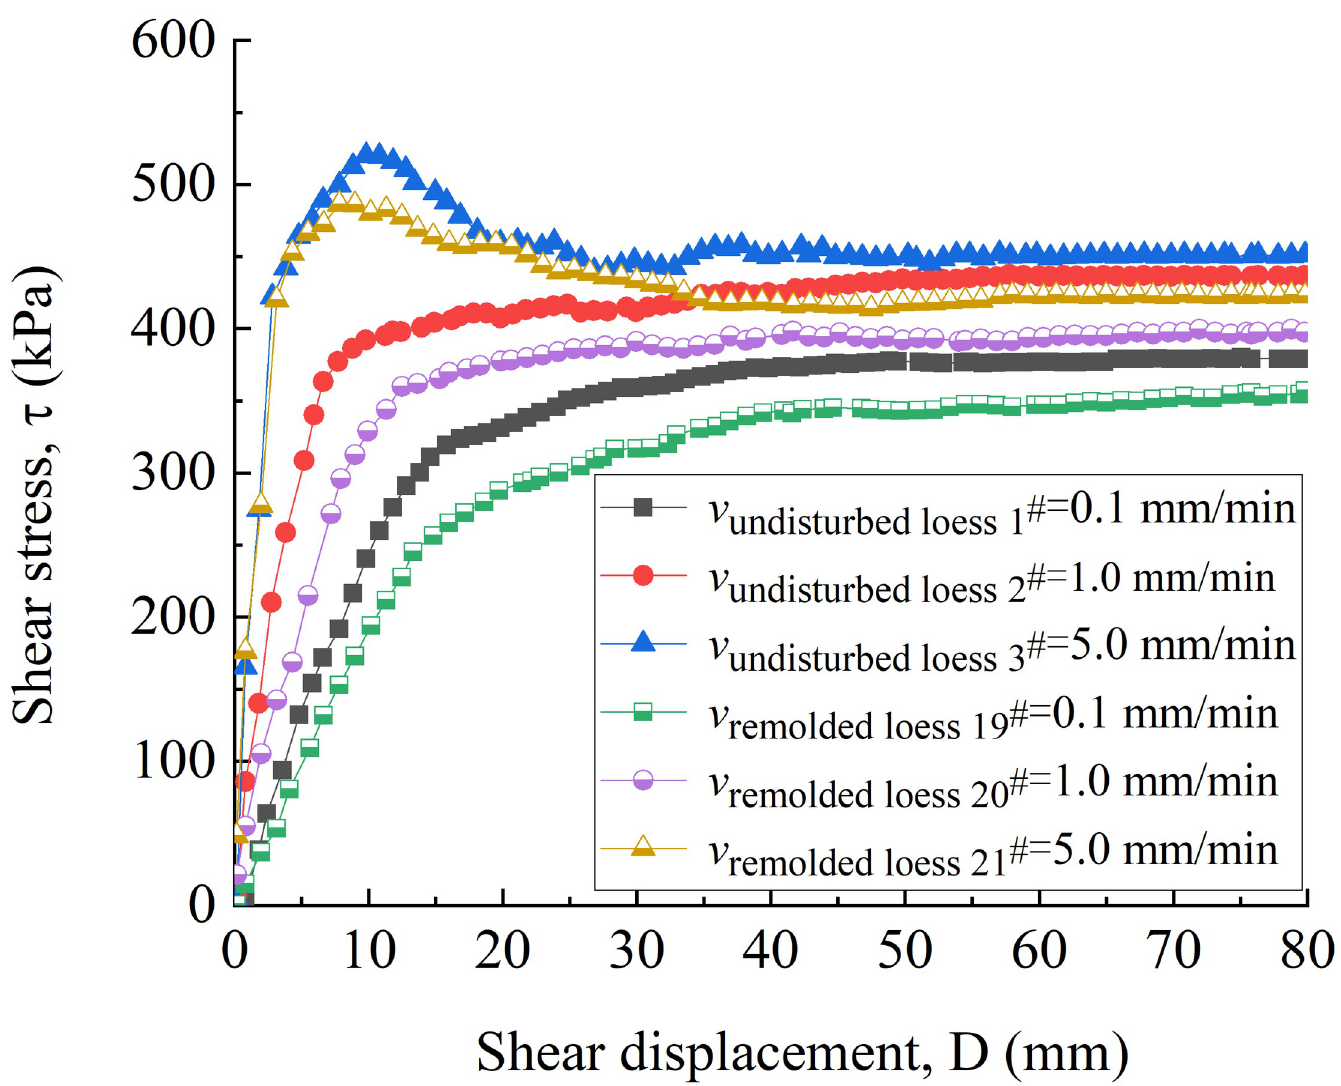
Fig 7. Shear stress-shear displacement curve of 1 # - 3 # undisturbed and 19 # - 21 # remolded loess specimens under different shear rates.